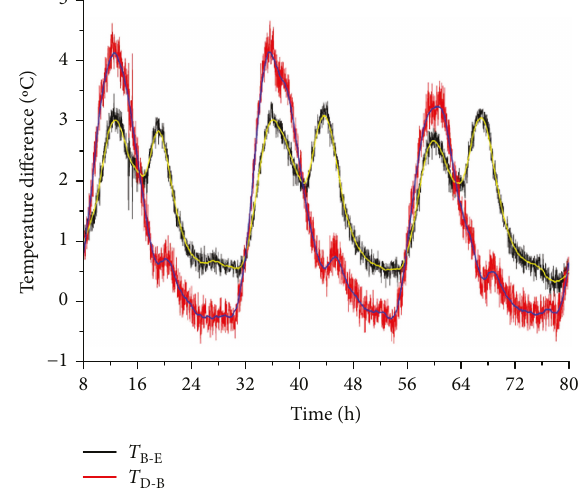
Figure 3: Comparison of the interior side temperature di ff erence between the upper, middle, and lower PCM